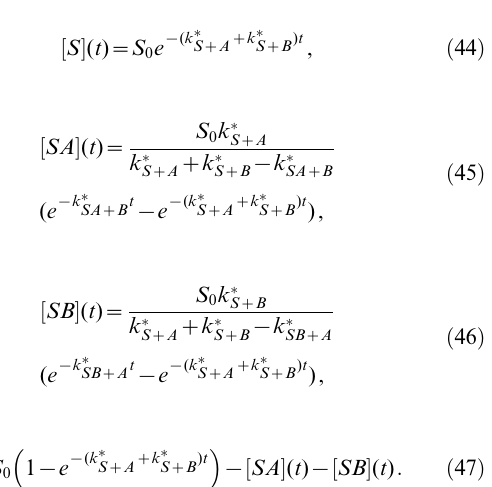
~ k (cid:3) ~ 0 : 3 and S z A SB z A ~ 0 : 1 k (cid:3) and SA z B S z B